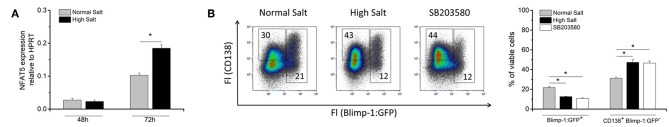
Effect of increased NaCl concentrations on NFAT5 expression and p38/MAPK phosphorylation in activated mouse B cells. (A) Cells from 48 to 72 h of LPS cell culture in presence (High Salt) or absence (Normal Salt) of additional NaCl were harvested and RNA was isolated. After cDNA reaction, real-time qPCR was performed to determine expression of NFAT5 in given samples. Results present NFAT5 expression relative to HPRT (average ± SD). Four independent measurements were performed in three technical replicates for each sample. (B) After 72 h, LPS activated B cells from the Blimp-1:GFP reporter mouse in the presence (High Salt) or absence (Normal Salt) of additional NaCl and SB203580 were analyzed by flow cytometry for their CD138 and GFP expression. Two different populations according to their CD138 expression and GFP fluorescence are indicated as: Blimp-1:GFP+ (Blimp-1:GFP single positive cells and Blimp-1:GFP/CD138 positive cells) and CD138+ Blimp-1:GFP− (CD138 single positive cells). Frequency of cells was shown on representative dot plots. The results show the summary of two independent experiments with a total of five independent B cell isolates (N = 2, n = 5). Data are presented as the mean ± SEM. *p ≤ 0.05; Mann-Whitney test.